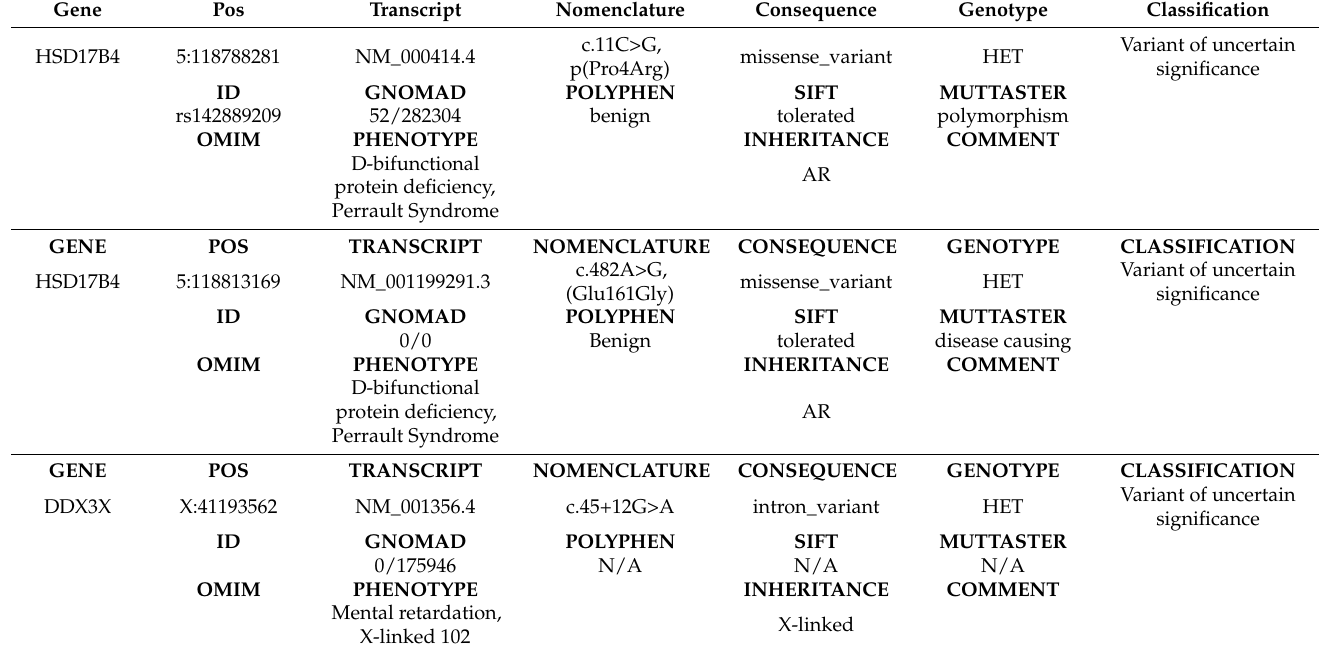
Table 2. Characterization of the Variant of Uncertain Significance (VUS) found in the exome sequenc- ing